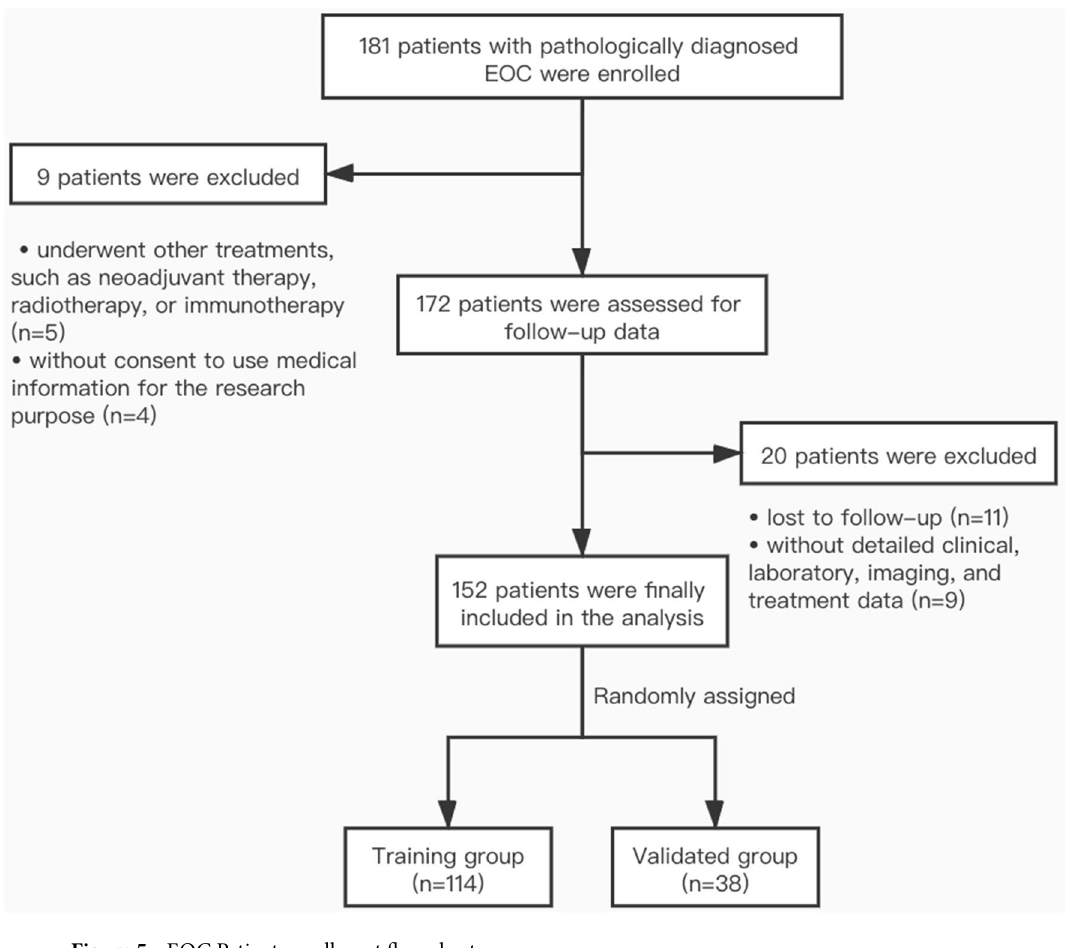
Figure 5. EOC Patient enrollment flow